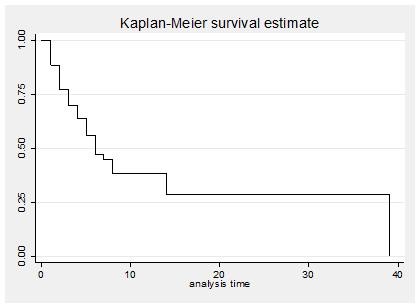
Time of death. The Kaplan-Meier curve describes (in weeks) the time of mortality.